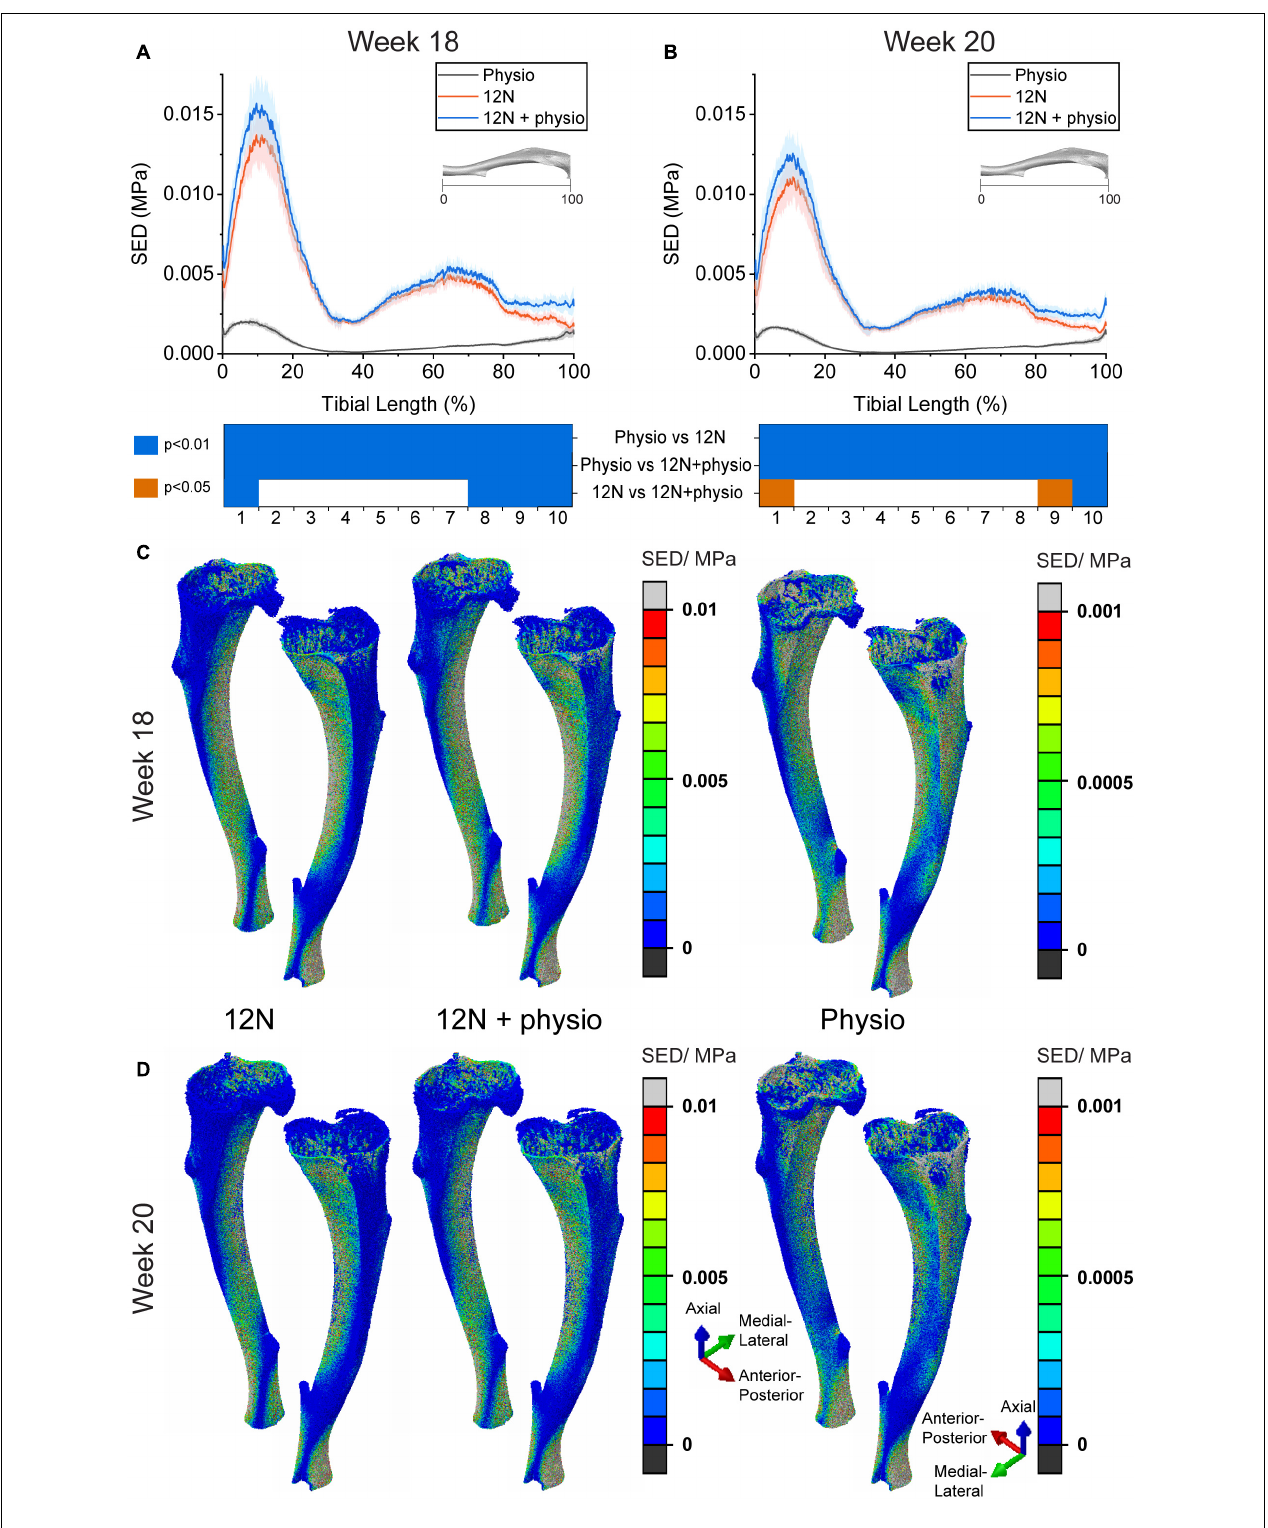
FIGURE 2 | Average strain energy density (SED) in the cross section of the tibia ( N = 6) due to different loading conditions (Distal: 0%, Proximal: 100%) at (A) week 18 and (B) week 20. 3D view of SED distribution in a typical mouse tibia (mouse 4) at (C) week 18 and (D) week 20. Physio: physiological load, 12N: nominal 12N axial load, 12N + physio: combined nominal 12N axial load superimposed on the physiological load. Heat map indicate significant difference between the loading conditions (Wilcoxon signed ranked test; p < 0.05: orange; p < 0.01: blue). Note the difference in scale for the color maps in the FEA plots.